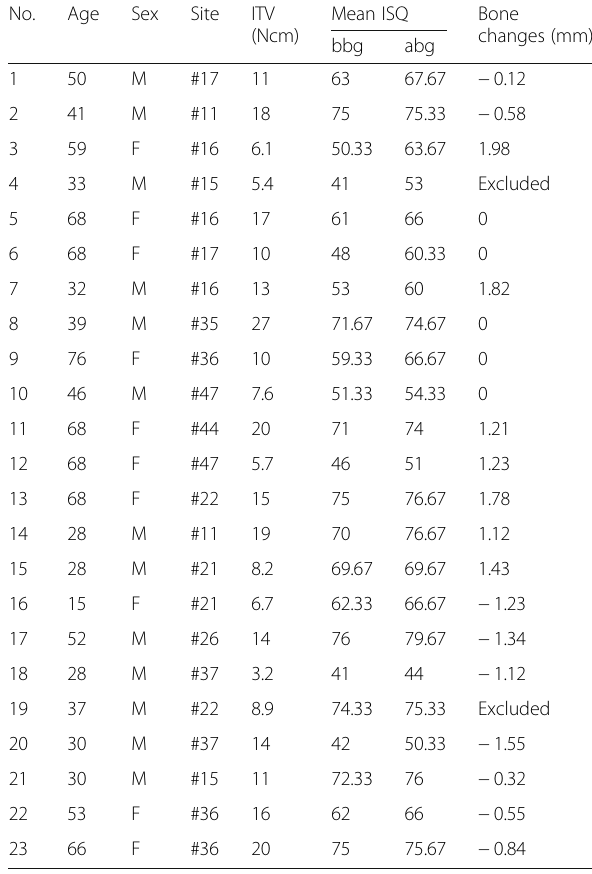
Table 1 Patient information and measurements of implant stability and bone changes after 1 year follow-up